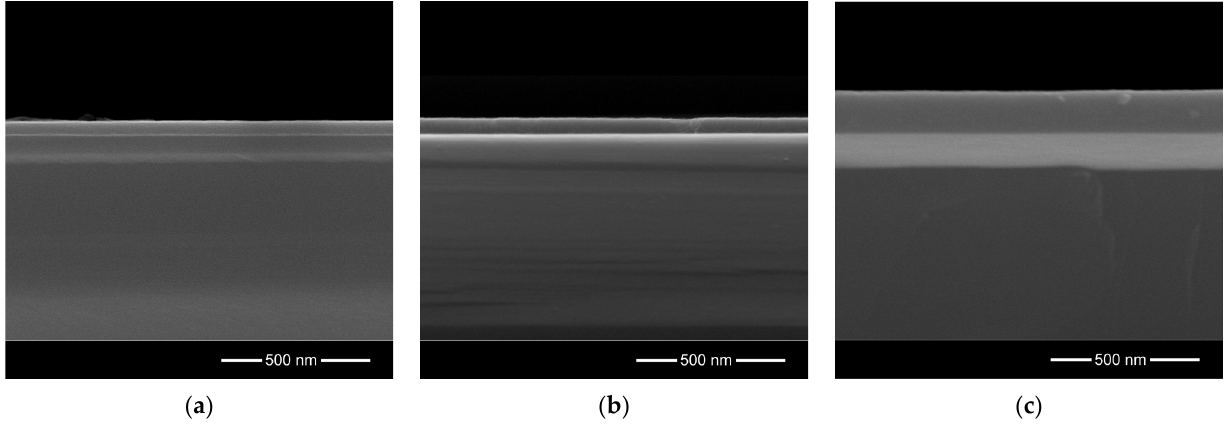
Figure 9. Cross-sectional view of the deposited layer when using the HiPIMS power supply and for the deposition times of ( a ) 5 min, ( b ) 10 min, and ( c ) 15 min. Table 4 summarizes the measured thickness for each presented sample. Table 4. Thickness of the deposited CrN layer.